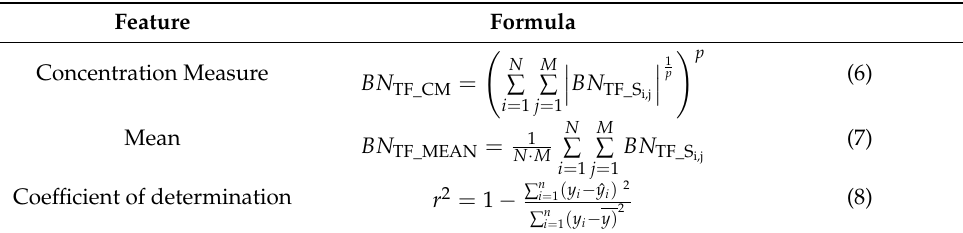
Table 4. Definition of analyzed parameters ( BN TF_S